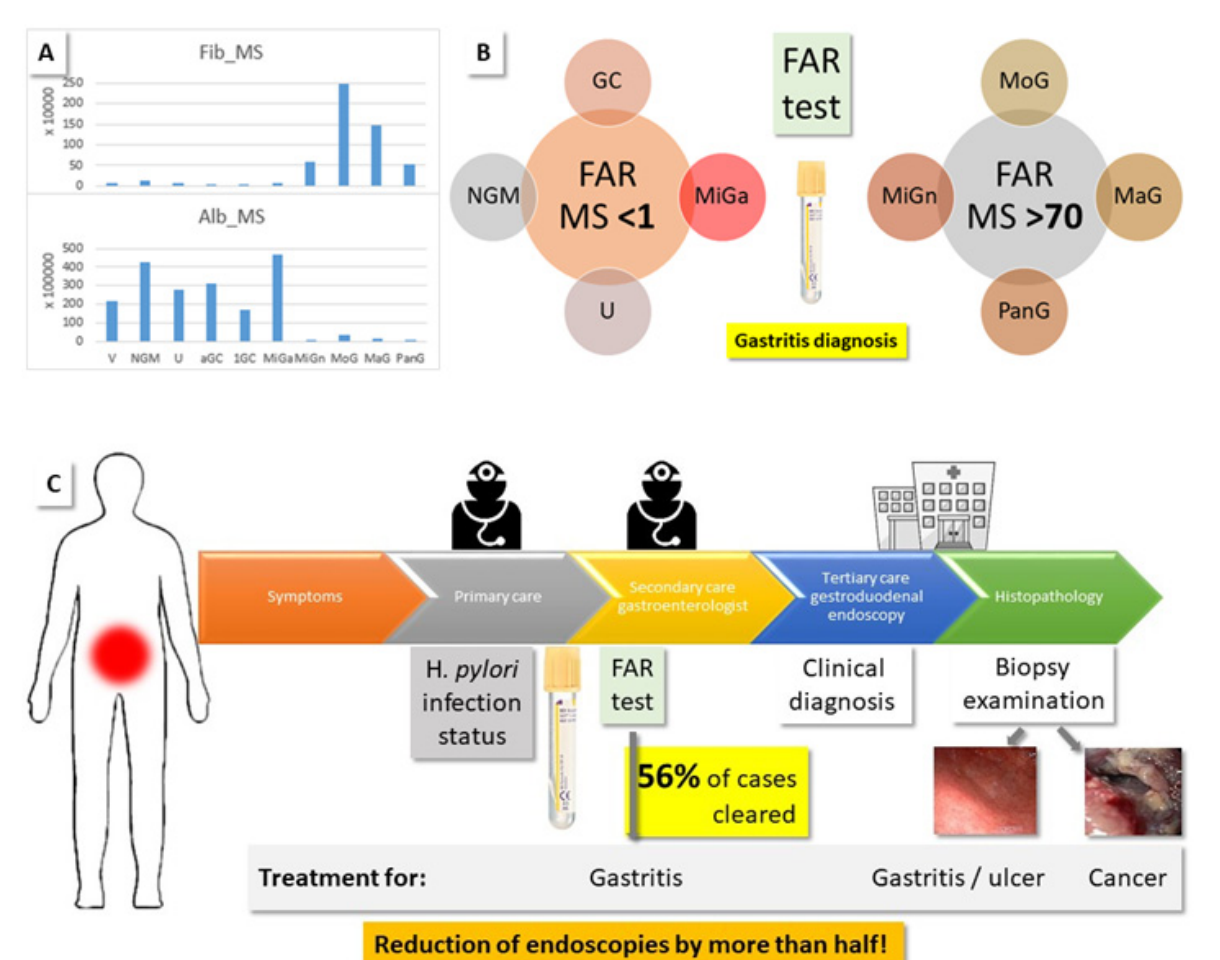
Figure 5. FAR identifies gastritis cases. ( A ) Average MS intensities for serum albumin and fibrinogen detected per patient group. ( B ) FAR-MS significantly distinguished gastritis samples from NGM, GC, U, and MiGa, as a result of hypoalbuminemia and increased serum fibrinogen. ( C ) Current procedure for patients with gastroduodenal symptoms: If the efforts of the primary care physician are not successful, a gastroenterologist is consulted. Persistent cases are referred to endoscopy, which clarifies the clinical diagnosis by histopathological examination of gastric biopsies. We suggest that a FAR lab test, in addition to the determination of the H. pylori infection status, can identify the gastritis cases without the need for endoscopy and, thus, reduce the number of medical procedures by about half (as calculated based on the present patient cohort and data). The serum albumin level is part of a standard panel of parameters determined in the clinical laboratory, e.g., in liver and kidney disease. Hypoalbuminemia was observed in protein-losing gastropathy [52,53]. H. pylori eradication helped in some of these cases, because H. pylori infection can lower the serum albumin level [54]. Fibrinogen is an acute- phase protein, i.e., its blood level rises in response to systemic inflammation or trauma by several orders of magnitude. Elevated levels of fibrinogen were suggested as the cause of thrombosis and vascular injury that may occur in inflammation or cancer [55]. In patients with Helicobacter associated chronic gastritis, significantly increased plasma fibrinogen levels were observed [56]. We noted differences between HPp and HPn samples (FAR-MS ranges: HPp: 79–87, 0.1–0.3; HPn: 70–116, 0.04–0.3), but they are of no importance in light of the major gap between the values for FAR-MS group 1 (GC, NGM, U, MiGa) and group 2 (gastritis, Figure 5), and were not further